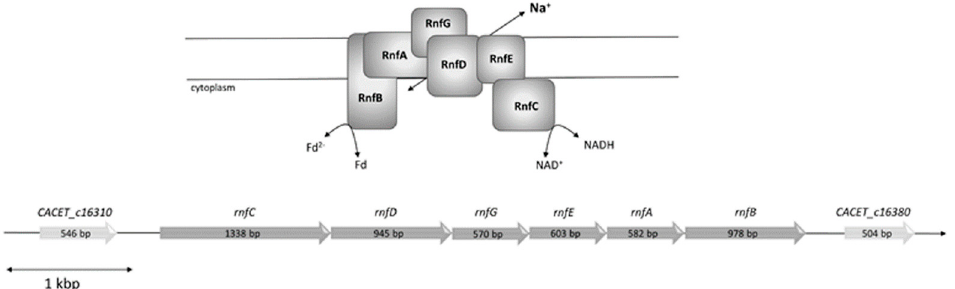
Figure 1. Model and genetic organization of the rnf operon in C. aceticum . The rnf genes are organized in a potential operon consisting of six genes, which code for a membrane-bound complex potentially consisting of monomers of each subunit. The first one is CACET_c16320 coding for RnfC, followed by CACET_c16330 coding for RnfD, CACET_c16340 coding for RnfG, CACET_c16350 coding for RnfE, CACET_c16360 coding for RnfA and CACET_c16370 coding for RnfB. The operon is flanked upstream by CACET_c16310, which has high similarity with an ATP-binding protein (sensor histidine kinase) and downstream by CACET_c16380, which has similarity with a transporter protein.